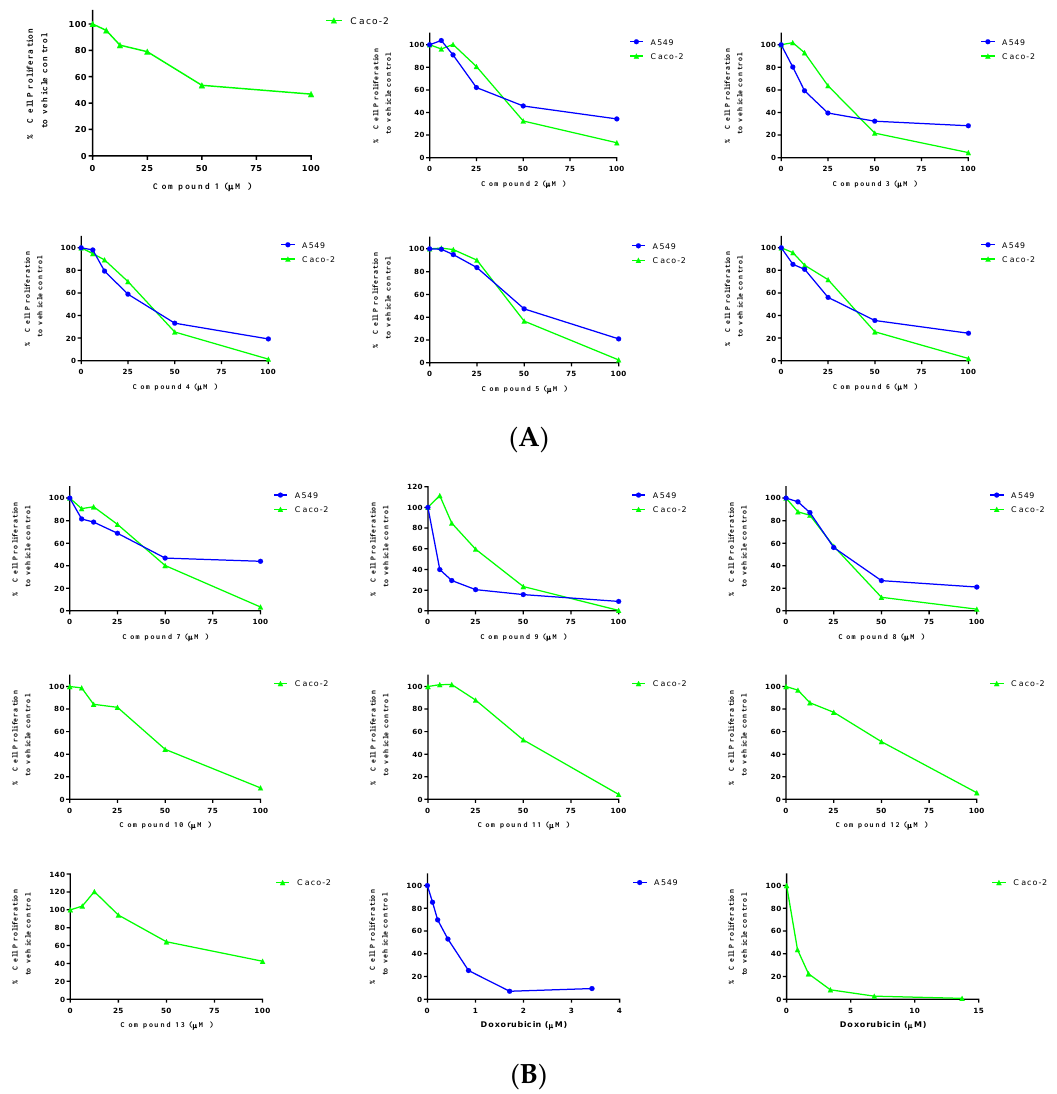
Figure 5. Concentration-response curve fits of the effect of isolated compounds 1 – 6 ( A ) and 7 – 13 ( B ) on the cell proliferation of Caco-2 (green triangles) or A549 (blue spheres). Cell proliferation was determined as % of vehicle control (MTT reduction assay) as detailed in the Experimental section.